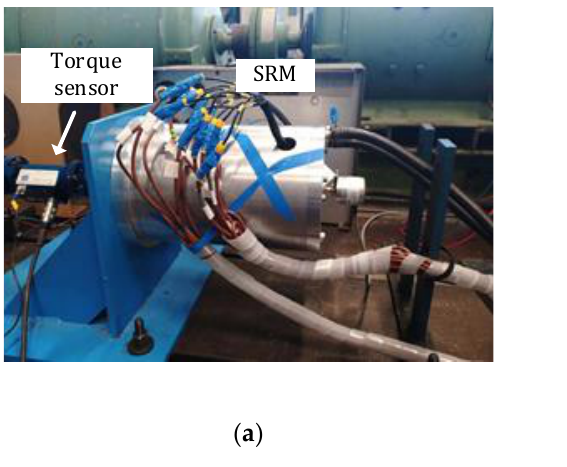
Figure 18. Prototype and setup of the proposed SRM: ( a ) the prototype of the proposed SRM; ( b ) the setup of the SRM system for the experiment.